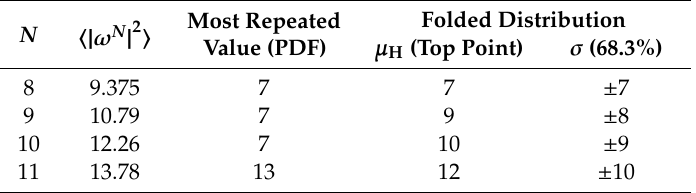
Table A18. Statistical parameters of SAW size for the FCC restricted lattice as a function of SAW steps (fixed: n = 5, Type 3) for selected